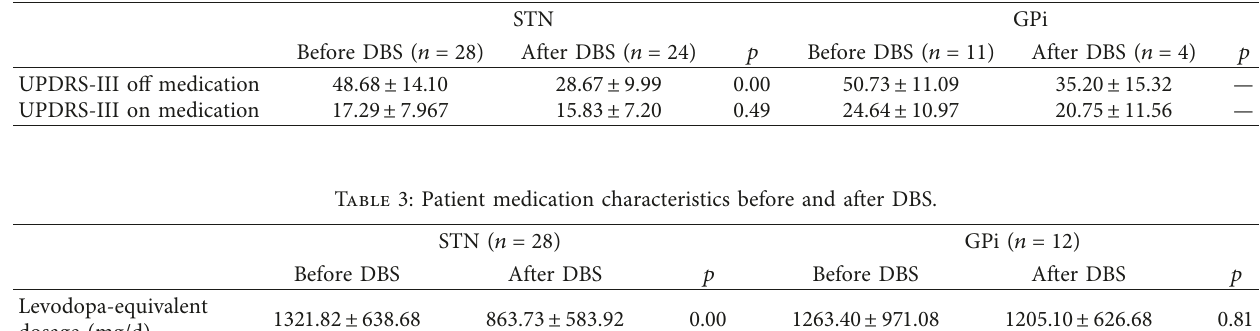
Table 2: Patient motor characteristics before and after DBS.